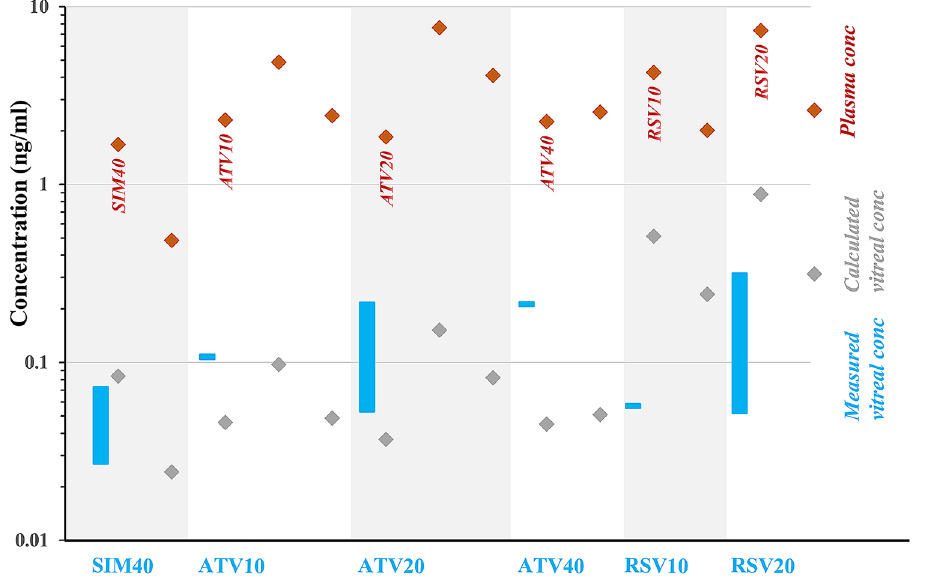
Figure 5. Graphical representation of the concentration of orally administered simvastatin 40 mg (SIM40), atorvastatin 10 mg (ATV10), 20 mg (ATV20), 40 mg (ATV40), and rosuvastatin 10 mg (RSV10), 20 mg (RSV20) in plasma (from the literature 22–34 , red diamonds) and in vitreous (from the present study, blue rectangles). Grey diamonds represent the calculated C v based on the corresponding plasma